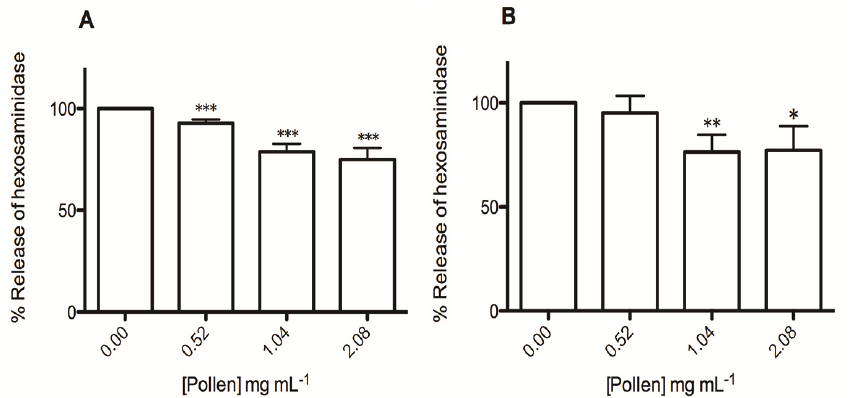
Figure 4. Effect of E. plantagineum bee pollen extract in β -hexosaminidase release.